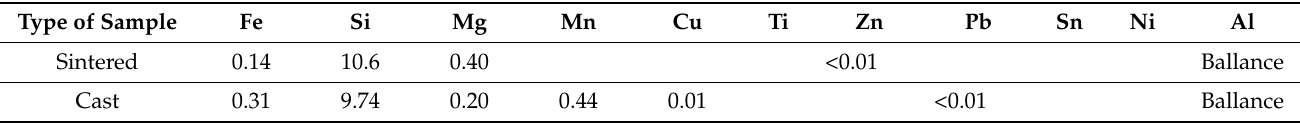
Table 2. The chemical composition of the AlSi10Mg alloy of specimens [wt. %].